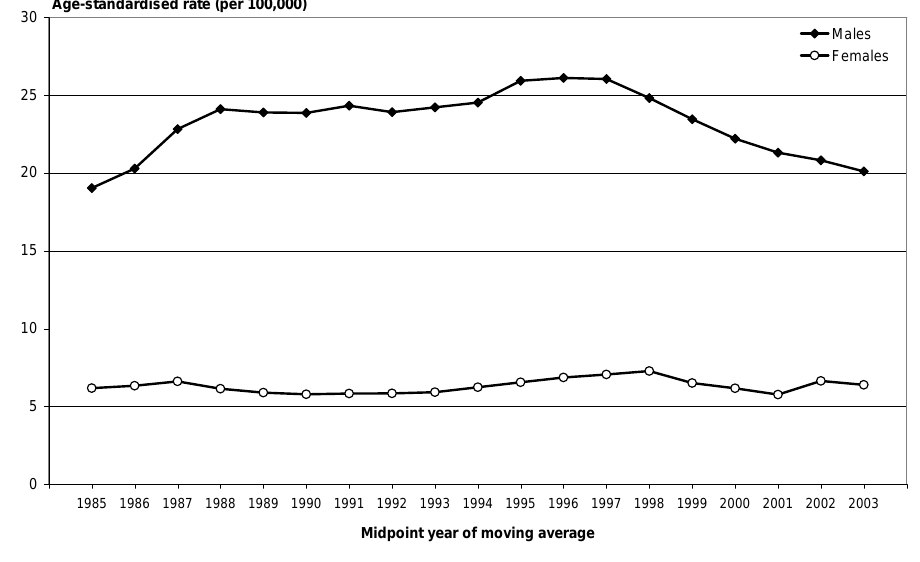
FIGURE 3. Suicide death rates, by sex, 3-year moving averages, 1984–2004. Source : New Zealand Health Information